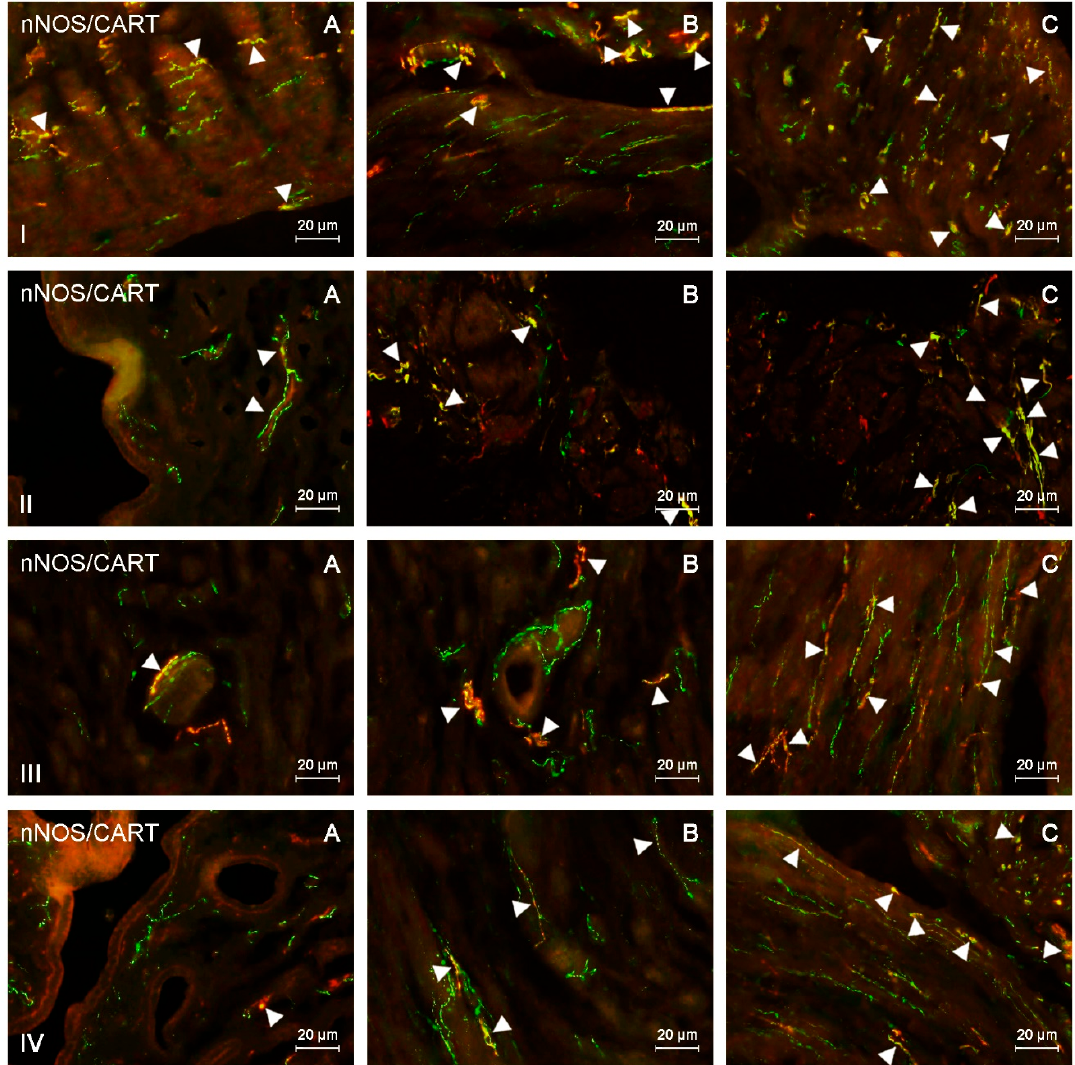
Figure 4. nNOS-positive nerves (nNOS + green) immunoreactive to cocaine- and amphetamine- regulated transcript (CART) (red) in the: (I) muscular layer of the corpus, (II) mucosal layer of the corpus, (III) muscular layer of the horns, (IV) mucosal layer of the horns of the uterine body of control animals ( A ) and pigs treated with low ( B ) and high ( C ) dose of bisphenol A. Nerves simultaneously immunoreactive to nNOS and CART (yellow) are indicated with arrowheads.